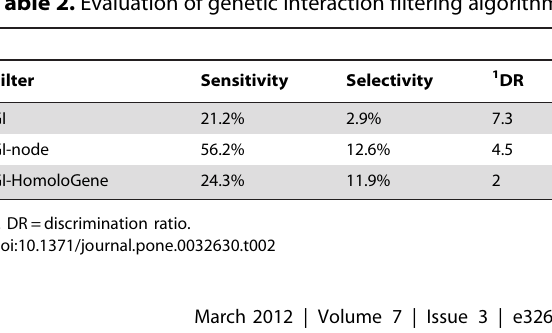
Table 2. Evaluation of genetic interaction filtering